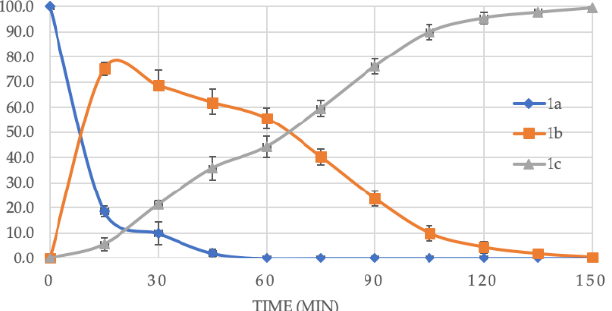
Figure 3. Time course of glycerol benzoylation performed with MML/ 1a (3/1), VB/ 1a (5/1) in THF at room temperature. Reaction progression was followed by GC and mixture composition is expressed in percentage. 1a = Glycerol; 1b = monobenzoyl glycerol; 1c = 1,3-dibenzoyl glycerol.